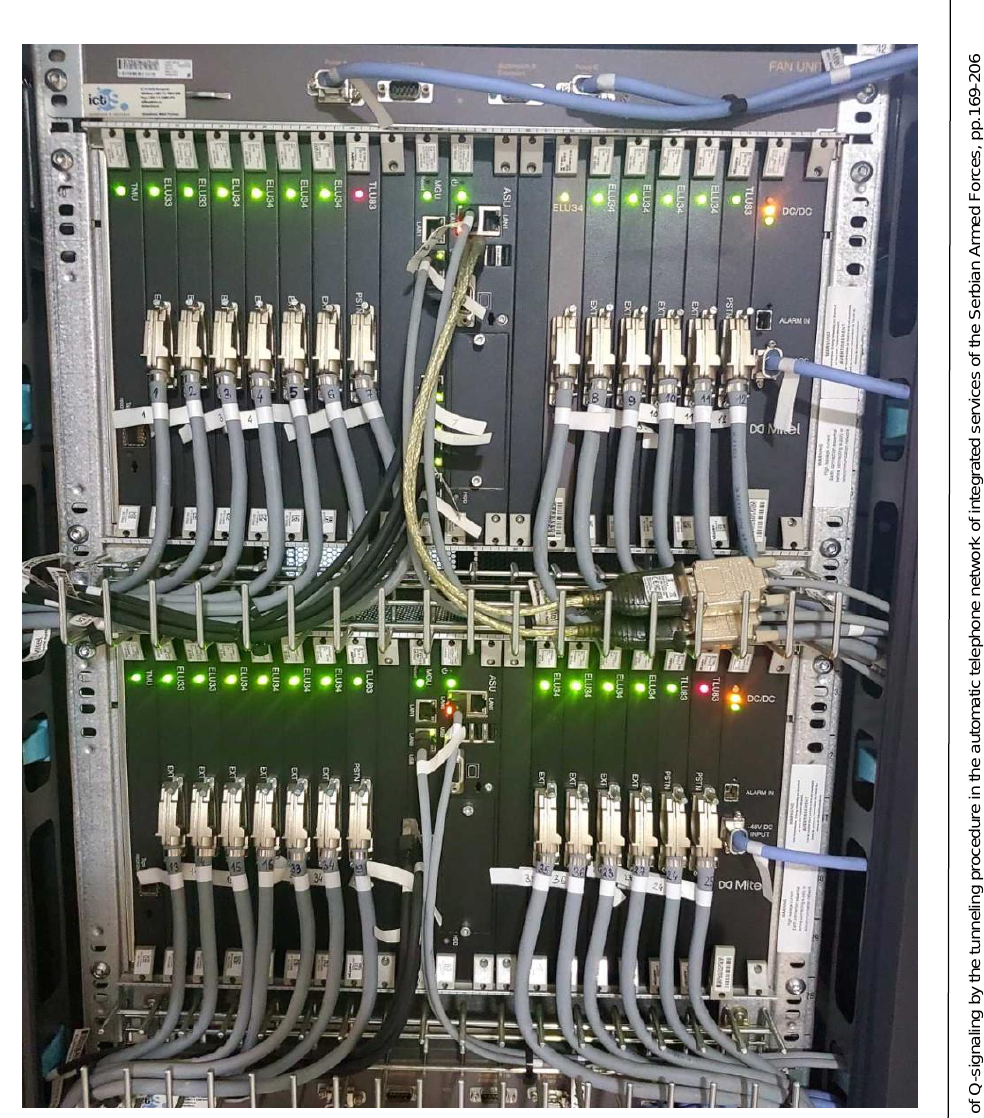
Figure 2 – Appearance of a modern, IP-oriented, transit PINX type MX-ONE Service Node 6.0 at a telecommunications center in the Air Force (Svrzić, 2019) Рис. 2 – Изображение современного, IP ориентированного, транзитного PINX типа MX-ONE Service Node 6.0 в телекоммуникационном центре